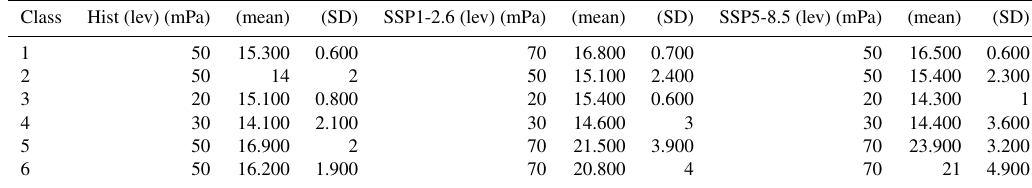
Table D2. The same as Table D1 but for MAM. Class